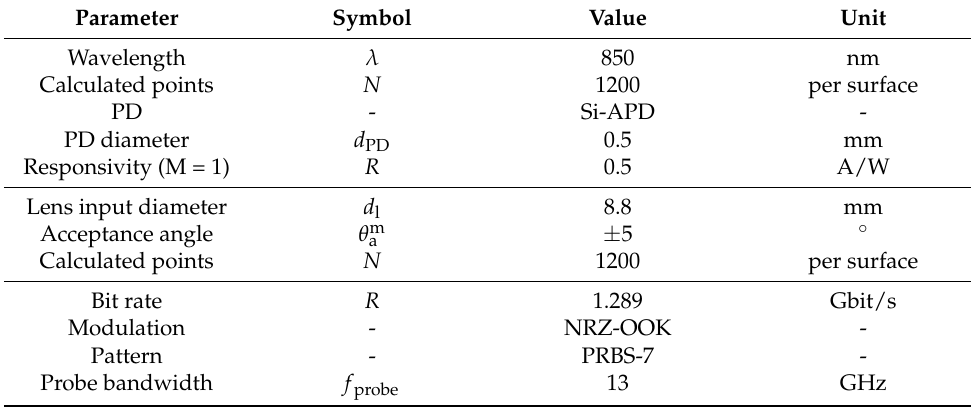
Figure 6. Experimental setup for the eye diagram and BER measurements. Table 1. Parameters of the optical wireless